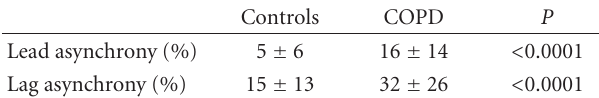
Table 4: The means ± standard deviations of asynchrony.